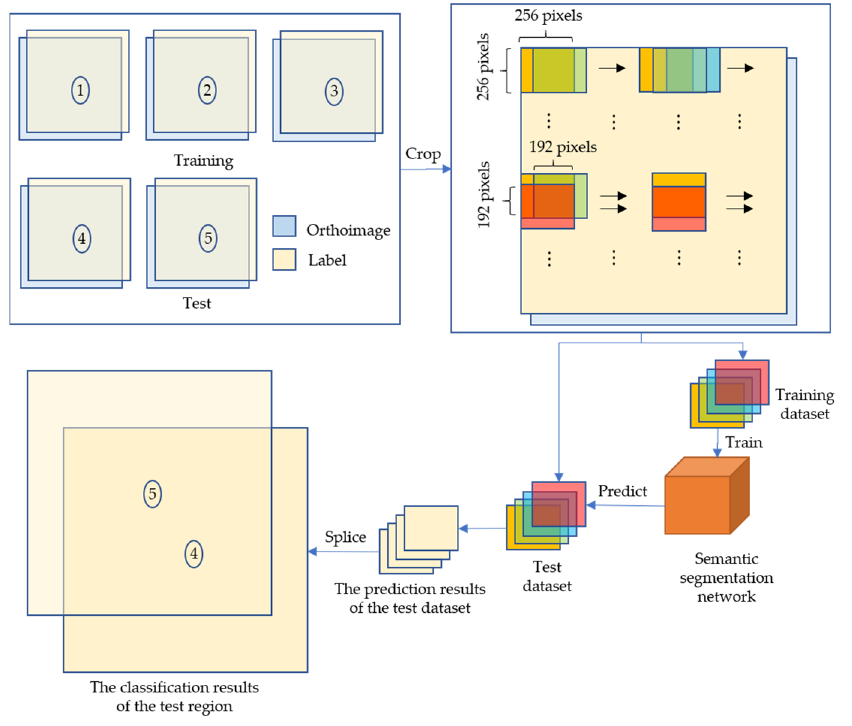
Figure 4. Flowchart of production datasets.